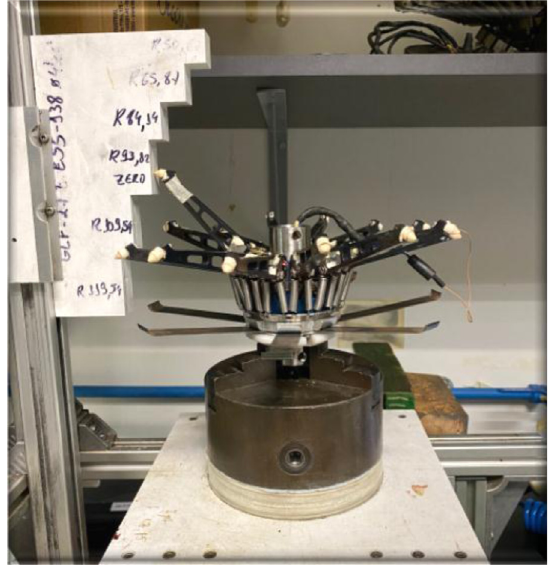
Fig. 4. Feeler PIG calibration on the bench.